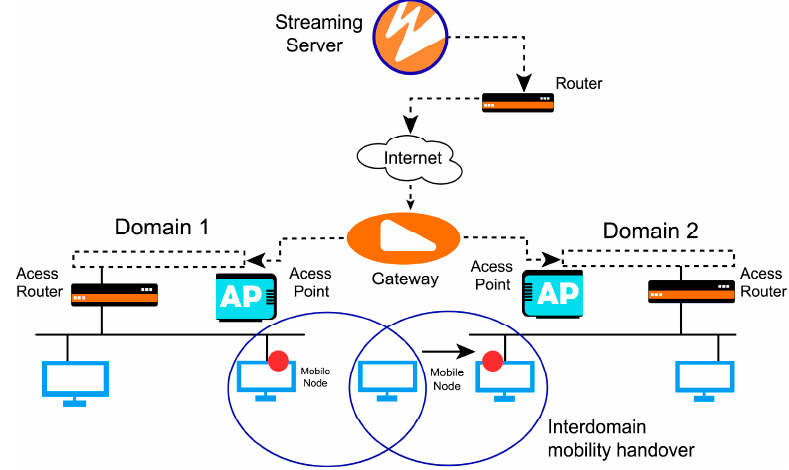
Figure 2. Virtual miniport/virtual driver.